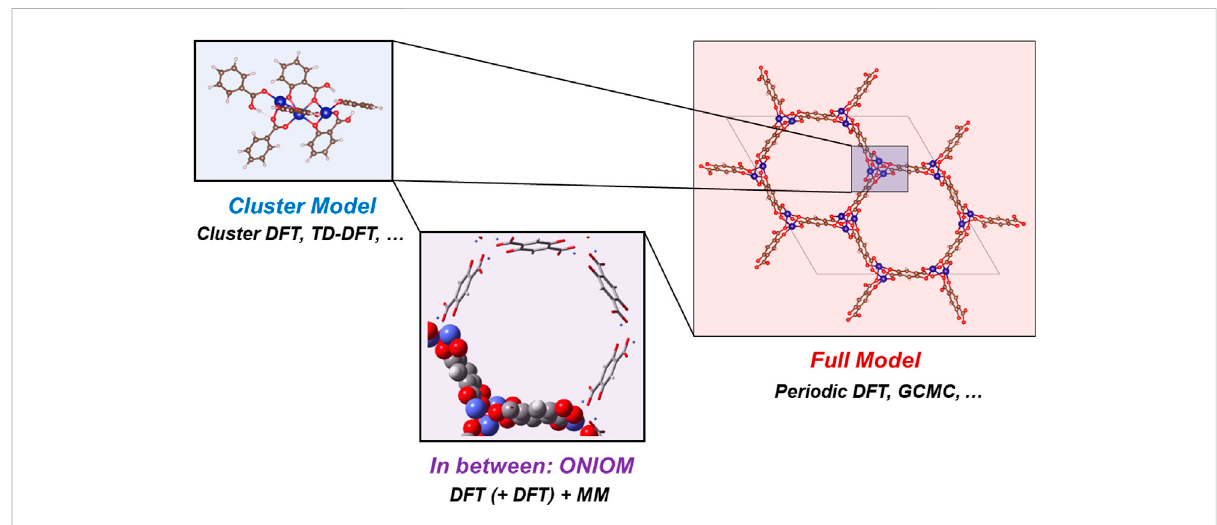
FIGURE 2 Illustration of different levels of models in computational study of